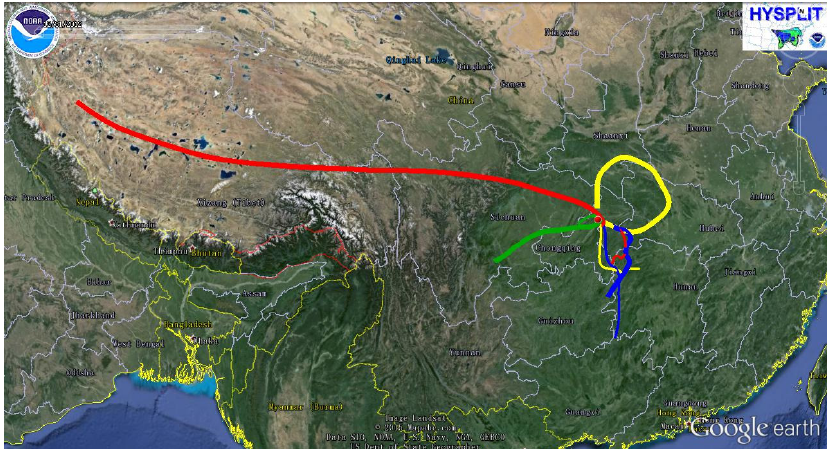
Figure 4. Forty-eight-hour backward air mass trajectories for the highest (bold) and lowest (thin) OC/EC ratio days in winter (red), spring (yellow), summer (blue), and fall